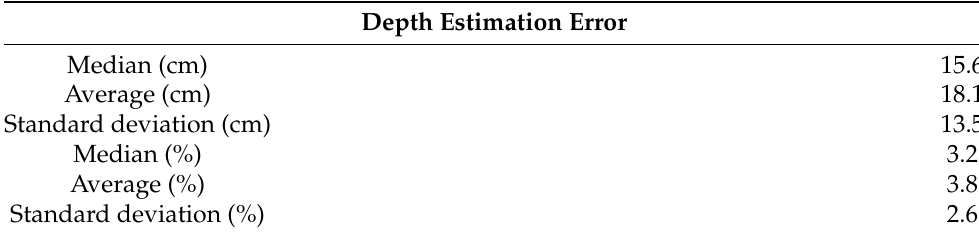
Table 2. Evaluation of depth estimation on 960 combined doosr and handles detection with an average distance of 3.75 m to the detected objects.